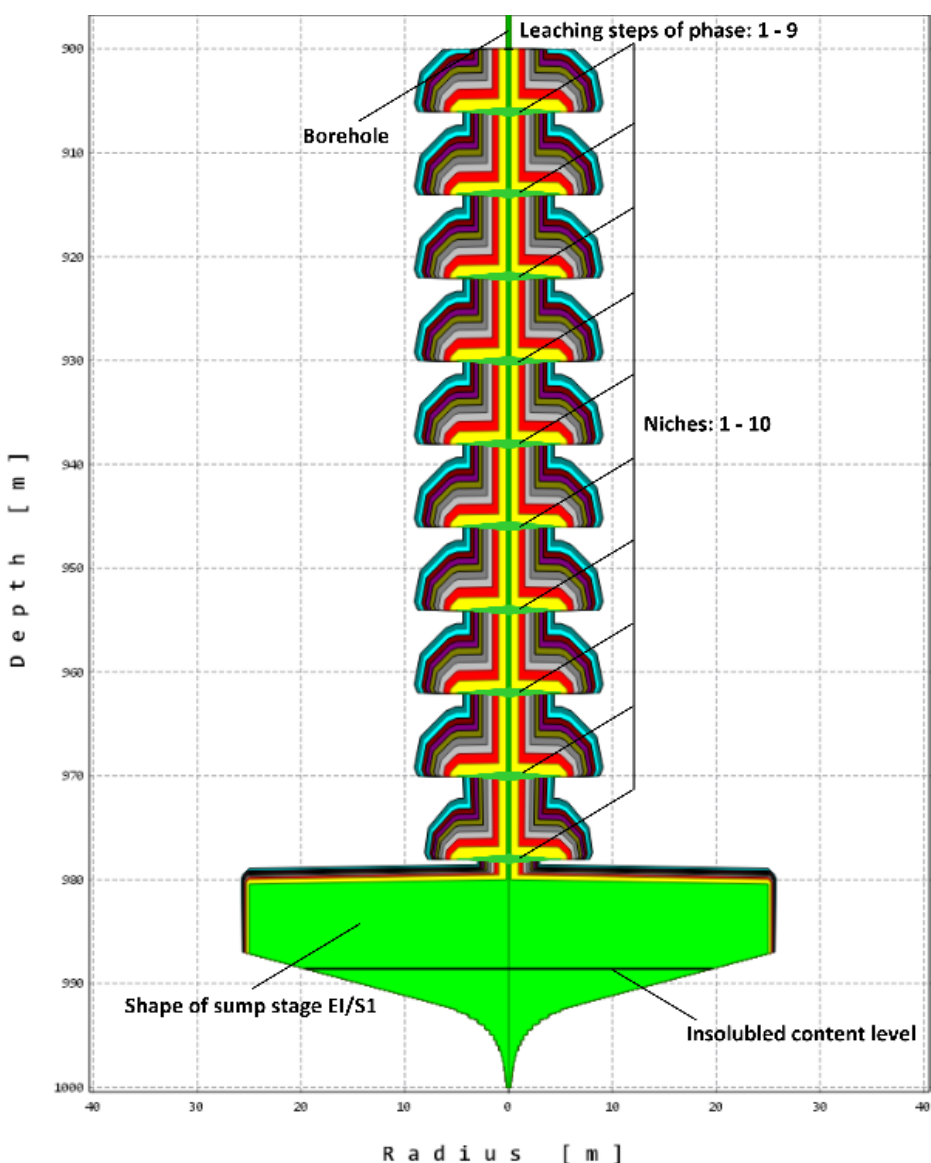
Figure 14. Shape of stage I phase of stage II after the end of the leaching for scenario 2—10 niches (S II/S II/S 2).